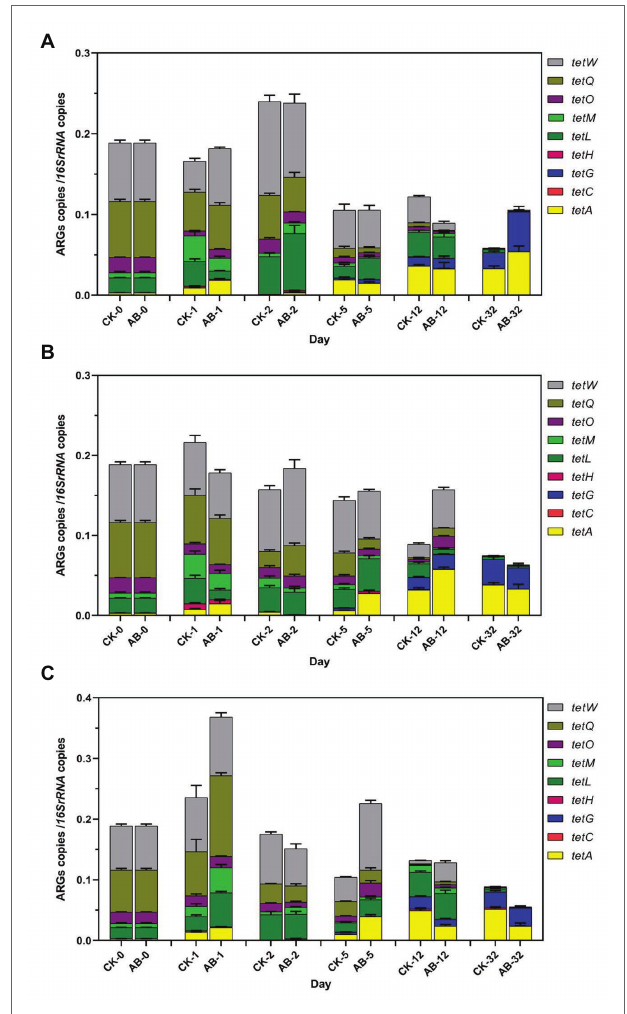
FIGURE 2 | Abundances of tetracycline resistance genes during swine manure composting. (A–C) refer to the upper, middle, and lower layers of compost, respectively. CK: the swine manure composting. AB: add 1% compound microbial agents in the swine manure composting. 0, 1, 2, 5, 12, and 32 are the days for